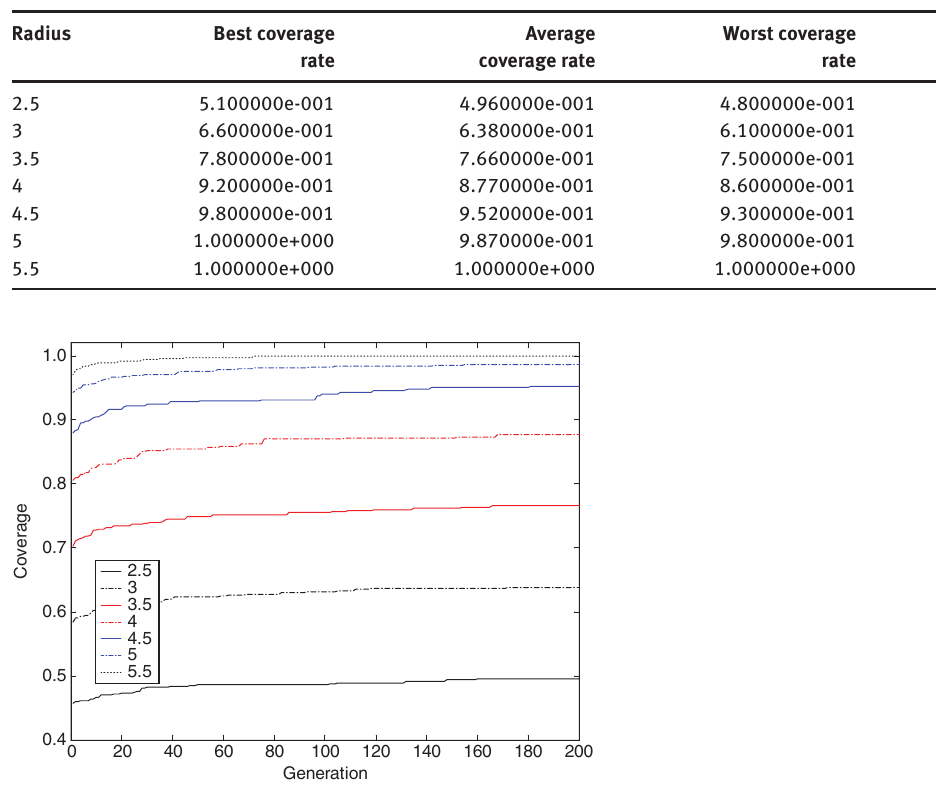
Figure 8: The Coverage Rate Curves When the Node Sensing Radius Was Set Different Values.